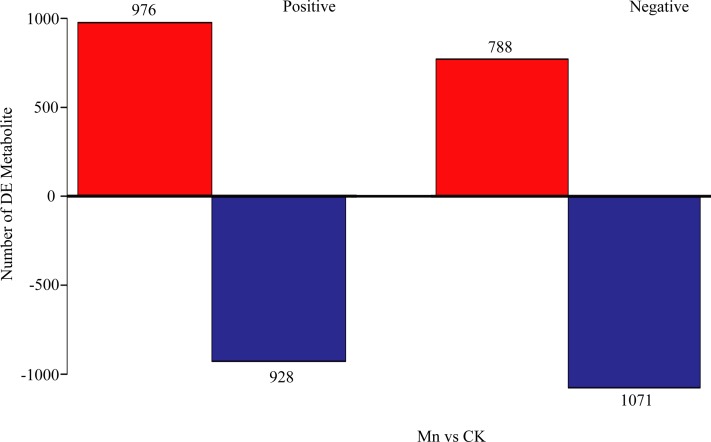
Investigation of differential metabolites comparing the Mn-treated samples to the control.CK, the control group without MnSO4 addition; Mn, the treatment group with 200 mg/kg MnSO4 addition. X-axis represents the samples, and Y-axis represents number of DE metabolites. The up-regulated metabolites are in red, and the down-regulated are in blue.